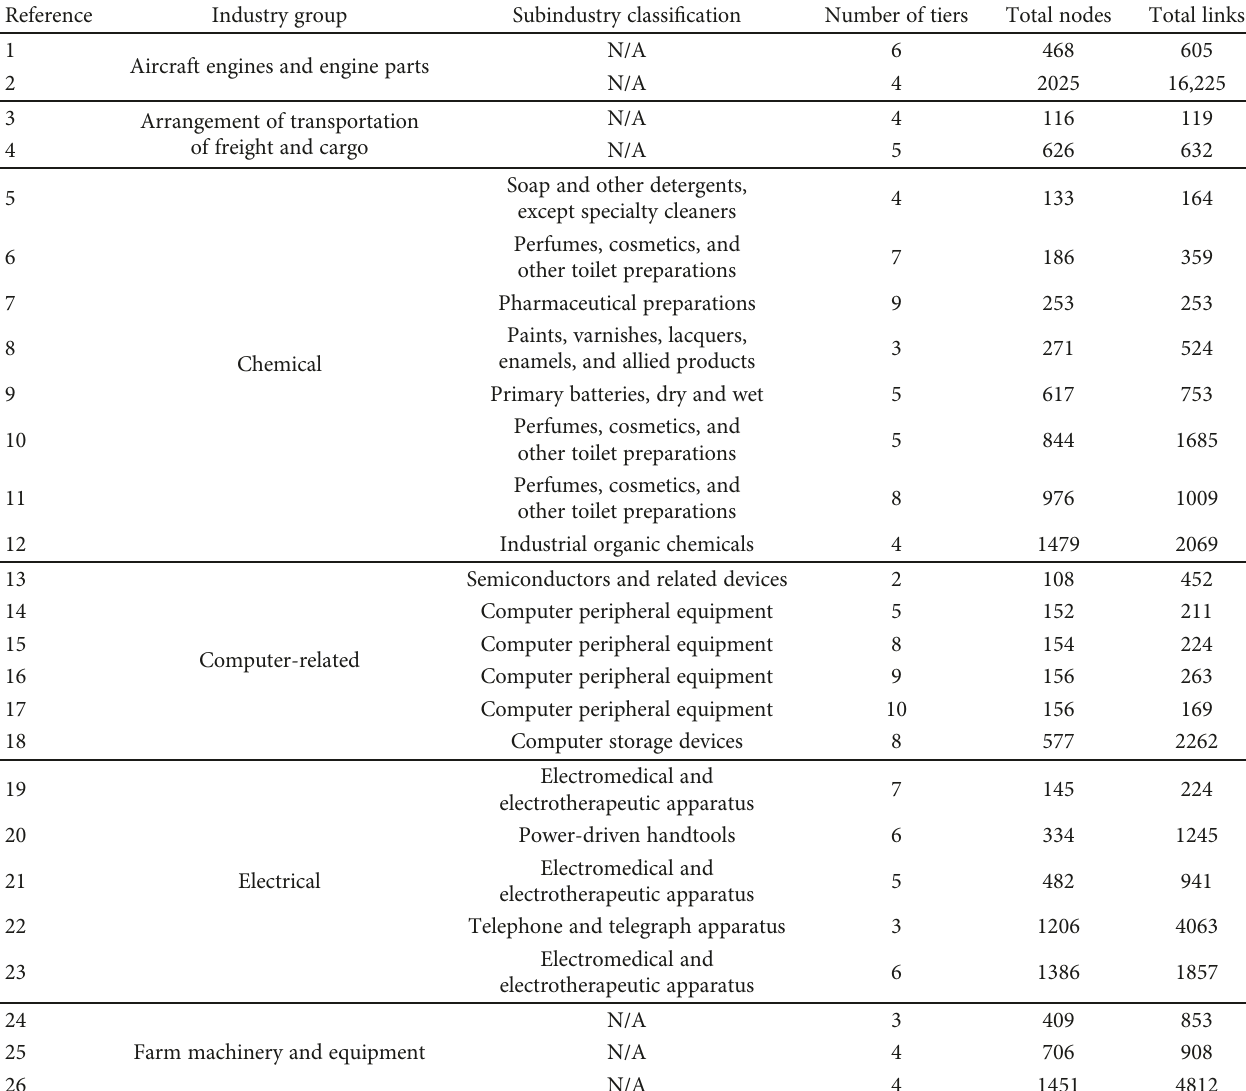
Table 1: Classi fi cation of directed material fl ow SCNs considered in the